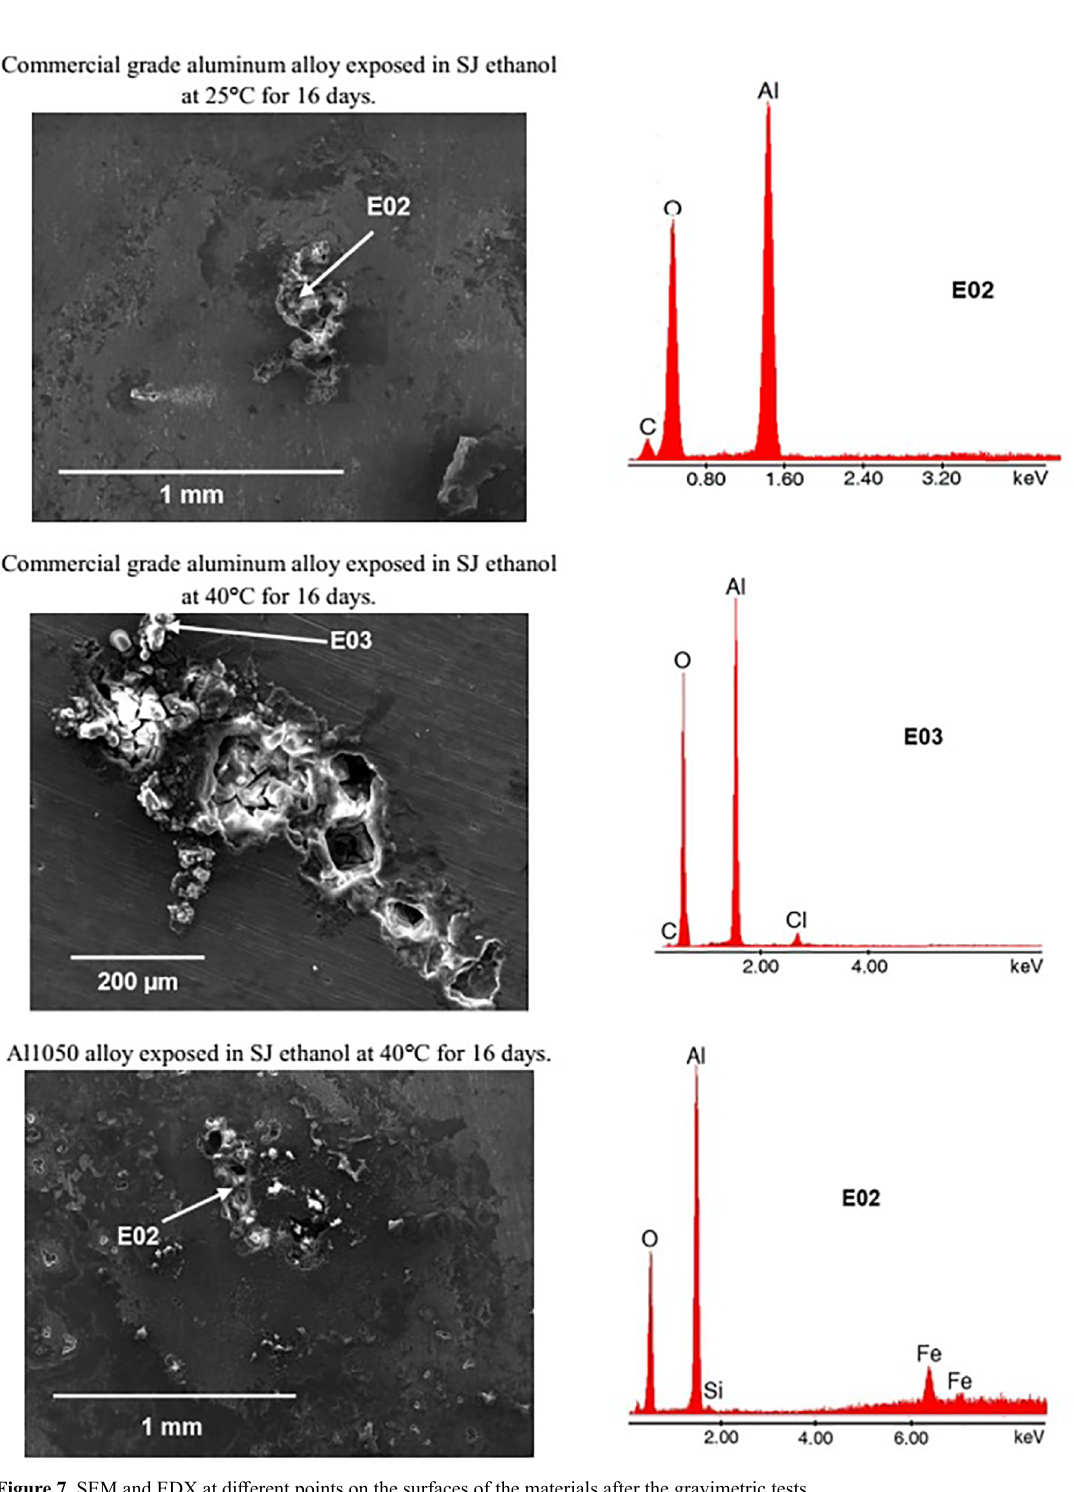
These results show that, for the case of the commercial grade aluminum, the pitting density increased slightly as the temperature increased, whereas for the Al 1050 alloy,